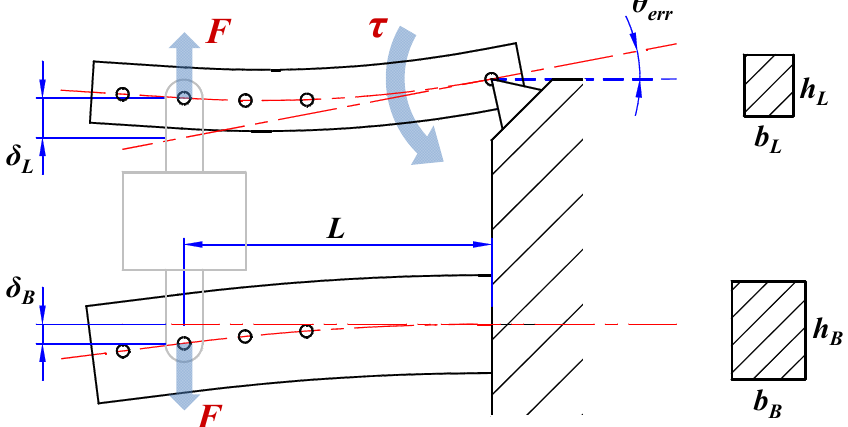
Figure 2. Angular deflection resulting from bending of the lever and base arms for external load. The longitudinal deformation of the load cell is not depicted here.